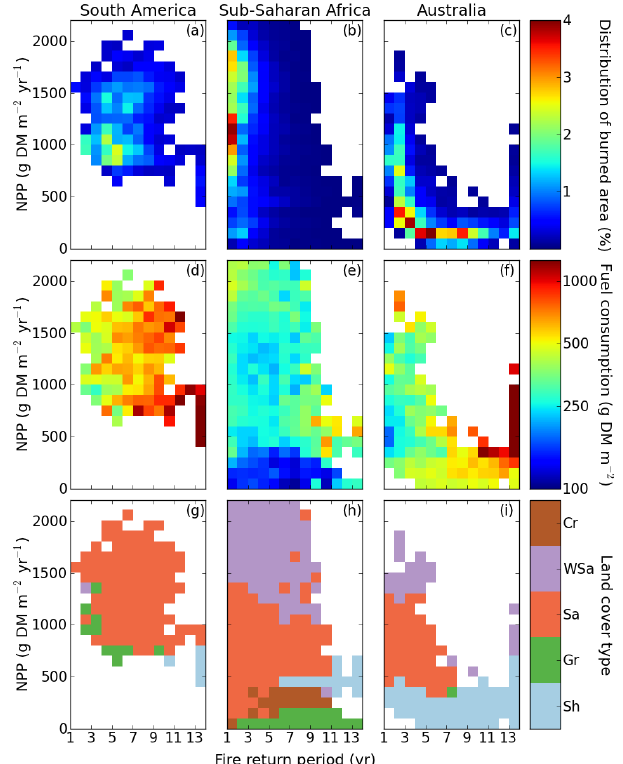
Figure 5. Distribution of burned area (a–c) , fuel consumption (d– f) and dominant land cover type (g–i) , all binned as a function of fire return periods and net primary productivity (NPP) for the three study regions (South America, Sub-Saharan Africa and Australia). Bins with burned area below 500km 2 yr − 1 are masked in white. Abbreviations of land cover type stand for cropland (Cr), woody savanna (WSa), savanna (Sa), grassland (Gr) and shrubland